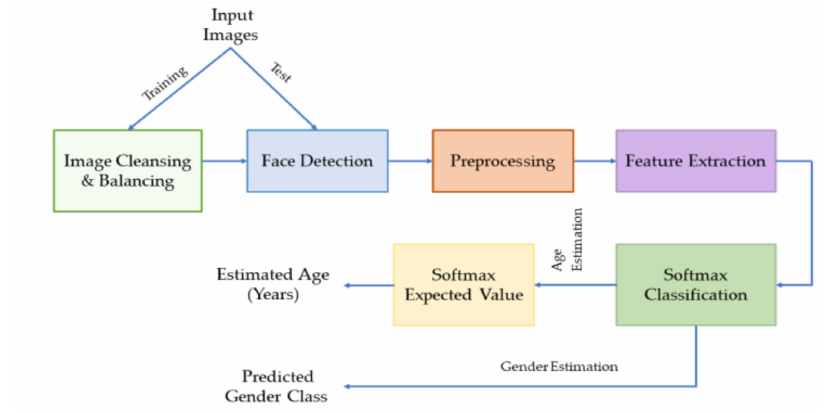
Figure 1. Schematic diagram of the proposed age and gender estimation method.